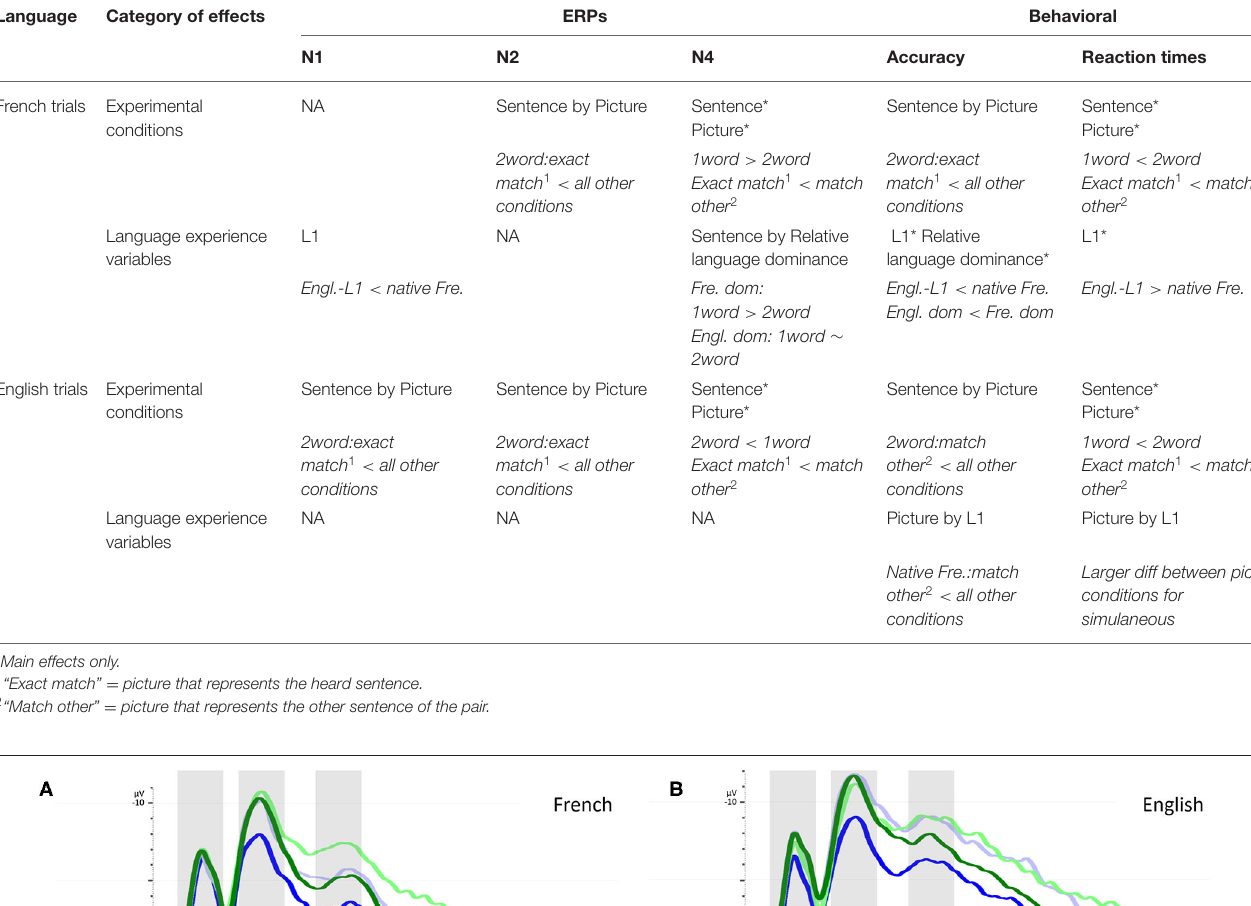
sentence condition ( or loge ) paired with a matching picture (picture of a gold bar—Fr. or